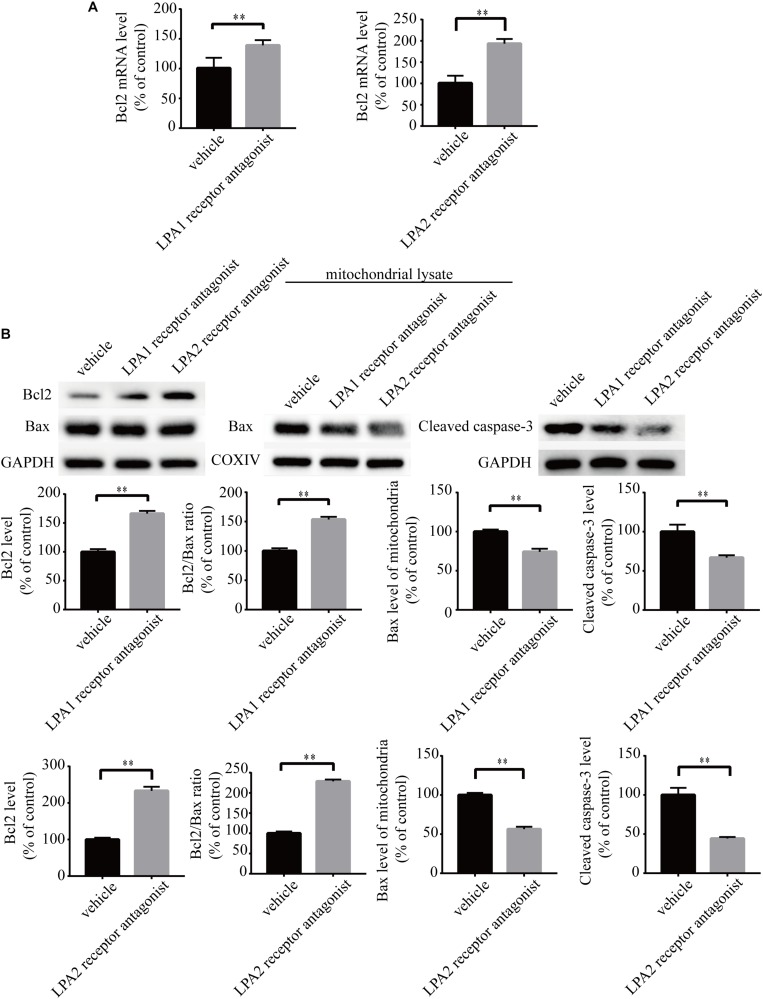
LPA1 receptor antagonist and LPA2 receptor antagonist attenuate the decrease of Bcl2 mRNA level, Bcl2 protein level, and Bcl2/Bax ratio as well as the activation of caspase-3. Q-PCR measures the Bcl2 mRNA level in neuronal PC12 cells treated with LPA (A). Western blot detects the Bcl2, Bax and cleaved caspase-3 protein levels in whole cells as well as the Bax protein level in mitochondria of neuronal PC12 cells (B). Data are mean ± SEM of five independent experiments. ∗∗P < 0.01.